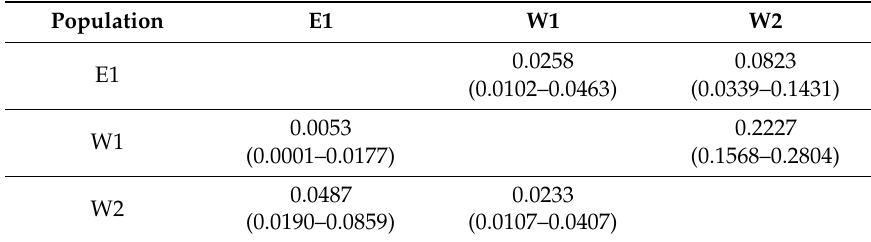
Table 5. Estimates of gene flow between Sitobion avenae biotypes of eastern and western provinces inferred from BayesAss analyses.